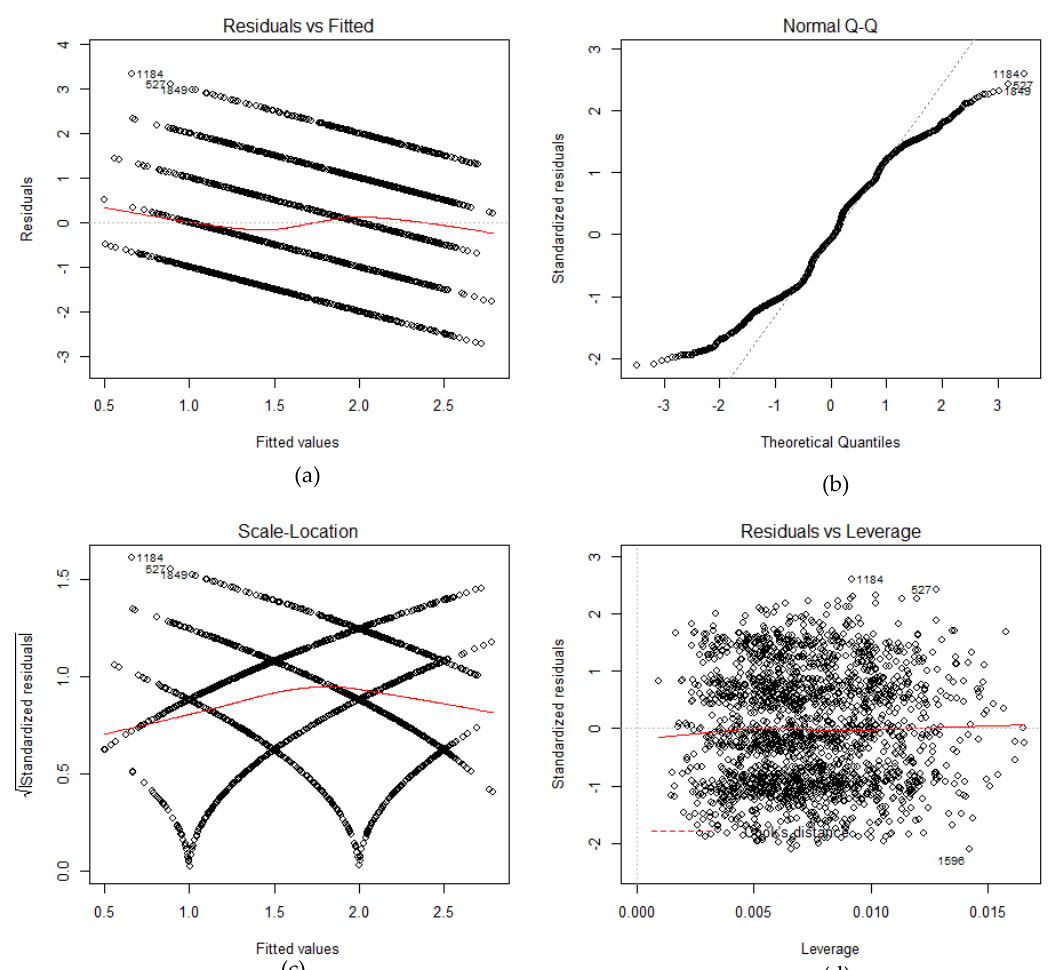
Figure 3. Diagnostics of the linear regression model: ( a ) Residuals vs. fitted values; ( b ) Normal Quantil-Quantil; ( c ) scale-location; and ( d ) residuals vs. leverage